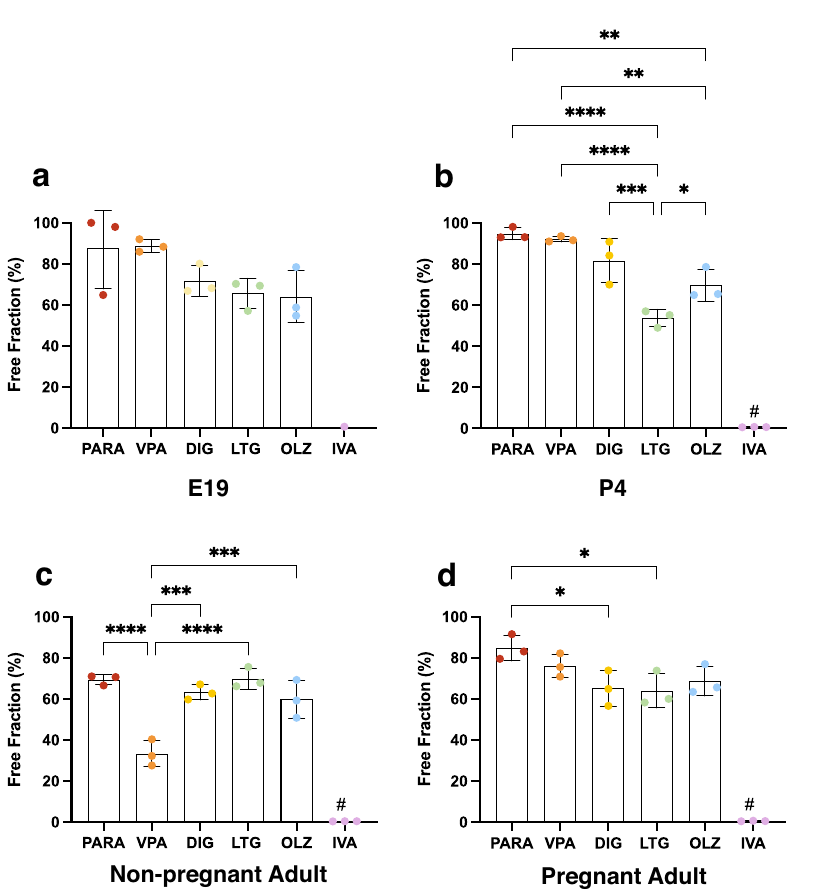
Figure 3. Free fraction of drugs in plasma of E19, P4, non-pregnant and pregnant female adult rats. Protein- free fraction/whole plasma concentration ratios (%) in plasma of E19 ( a ), P4 ( b ), non-pregnant ( c ) and pregnant female adult rats ( d ) spiked with paracetamol (PARA), valproate (VPA), digoxin (DIG), lamotrigine (LTG), olanzapine (OLZ), or ivacaftor (IVA) with respective [ 3 H]-labelled drugs. Mean ± SD where appropriate; n = 1–3. One-way ANOVA with Tukey’s multiple comparisons; * p < 0.05, ** p < 0.01, *** p < 0.001, **** p < 0.0001. # indicates p < 0.0001 with all other